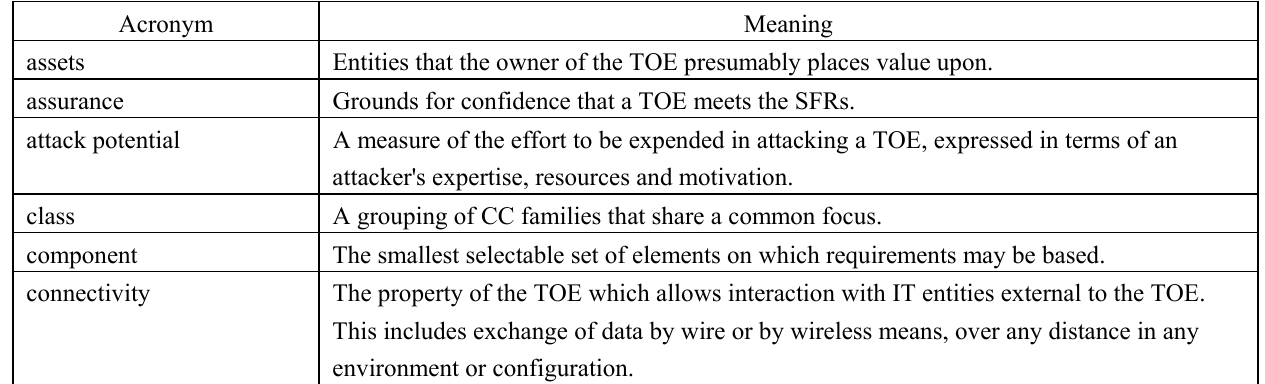
Table 1. Common Criteria related terms and acronyms